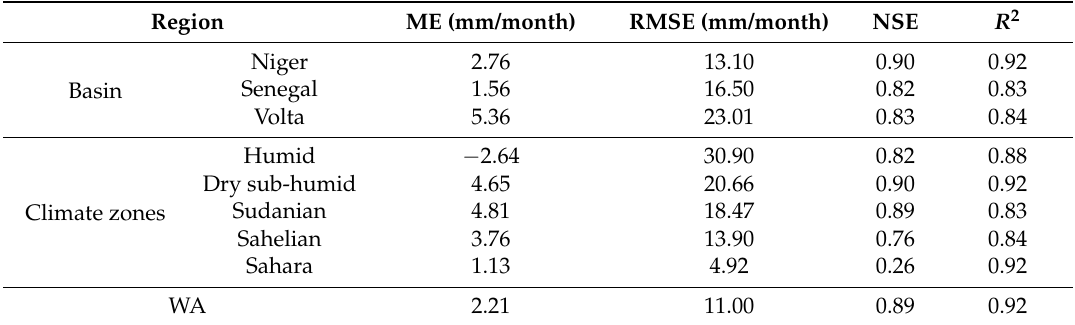
Table A1. Area-averaged statistics for backcasted ARCv2 rainfall estimates over river basins and sub-climatic zones (see Figure 1 for the